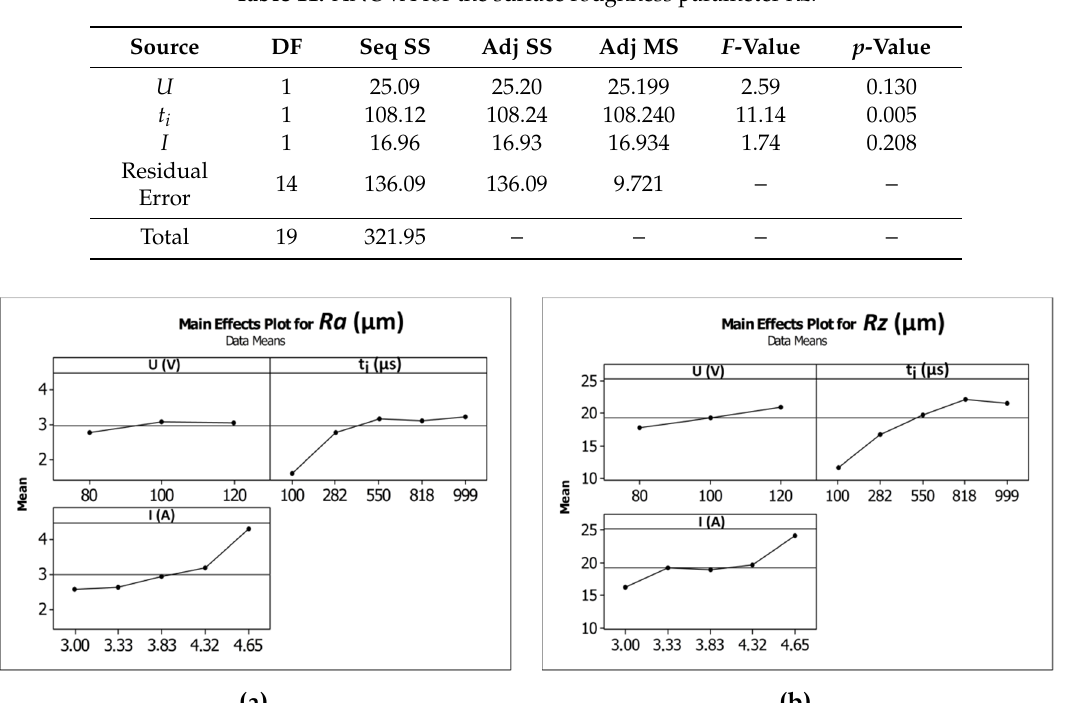
Figure 12. Influence of the machining parameters ( U , t i , I ) on the average values of surface roughness parameters. ( a ) Ra and ( b ) Rz .